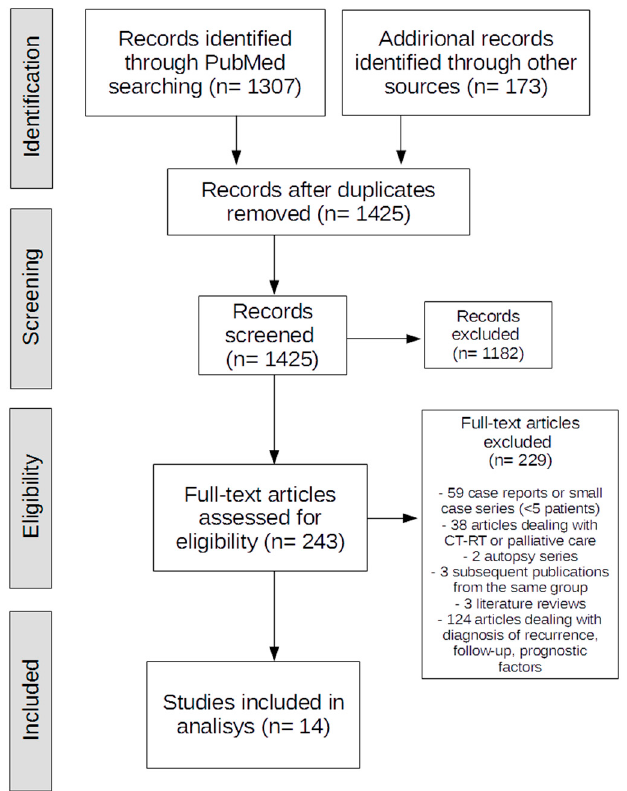
Figure 1. Literature review according to the 2009 Preferred Reporting Items for Systematic Reviews and Meta-Analyses PRISMA guidelines.